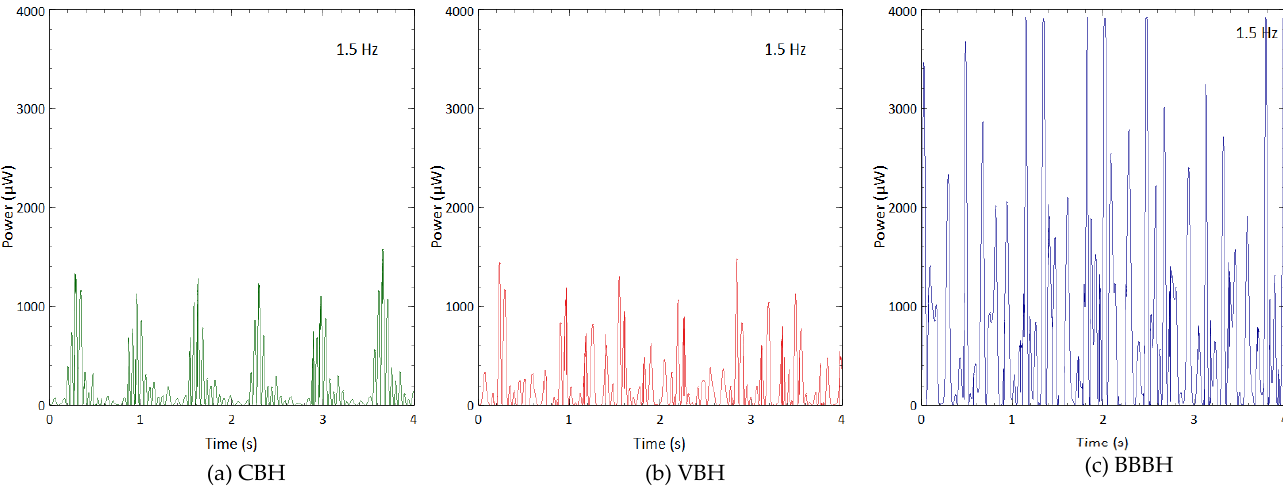
Figure 15. Power generated by ( a ) CBH, ( b ) VBH, and ( c ) BBBH for human running motion (1.5 Hz)